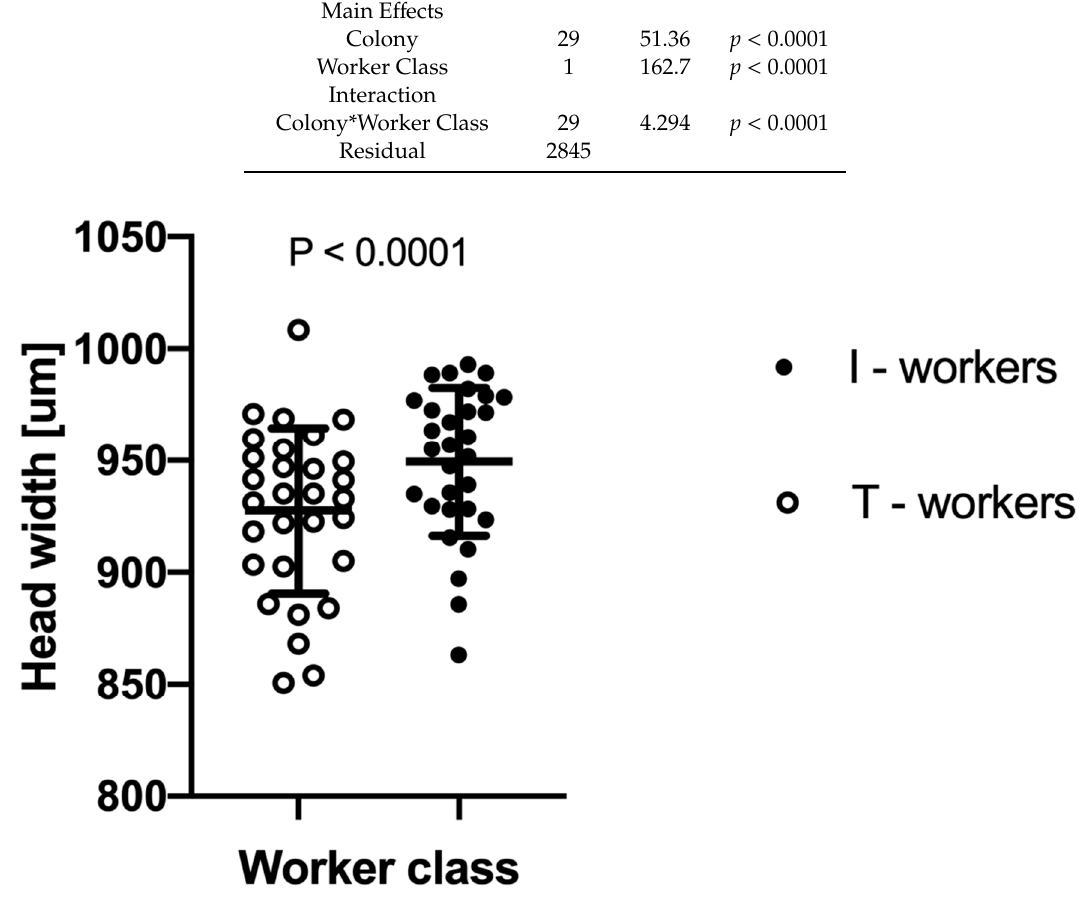
Figure 2. The di ff erence in mean head width between Lasius niger foraging workers attracted to tuna baits (T-workers) and workers collected directly from the nest (I-workers). Each dot indicates an average head width within a given colony. Whiskers denote standard deviations (SD).